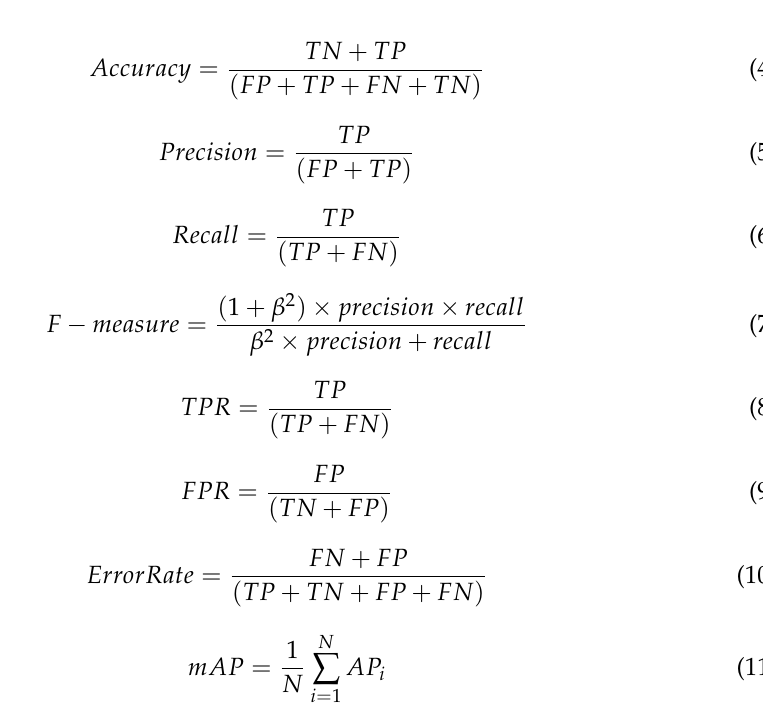
Table 3. Different hyper-parameters of the proposed algorithm. Parameter Without DA With DA Weight Decay 5 × 10 − 4 5 × 10 − 4 Momentum 0.90 0.90 Iterations per Epoch 7 38 Maximum Iterations 700 3800 Batch Size 16 16 Maximum Epochs 100